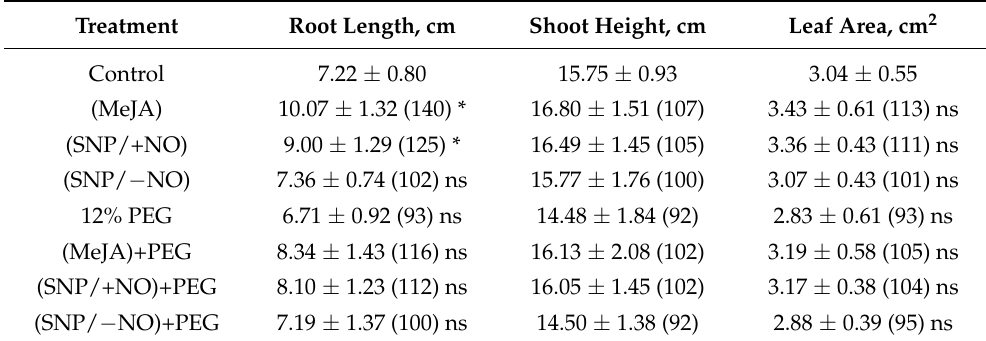
Table 1. Growth parameters of 7-day-old wheat plants pretreated with 2 × 10 − 4 M SNP or 10 − 7 M MeJA over 24 h and subsequently applied by 12% PEG during 24